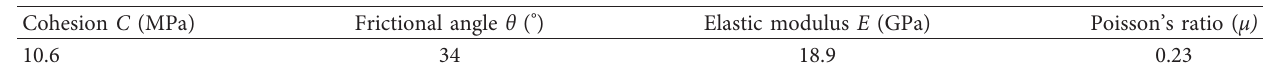
Table 2: Parameters of the calculation